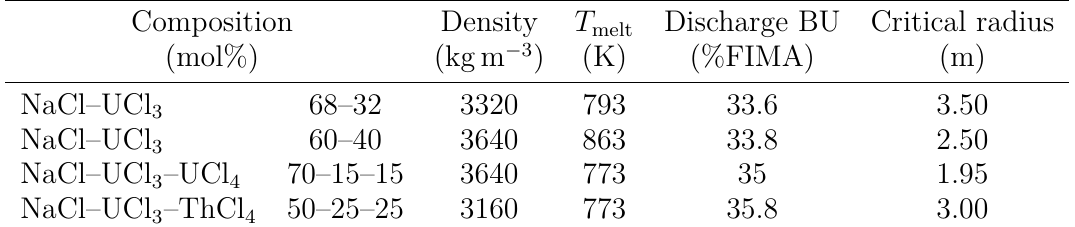
Table III: Candidate chloride fuel salts considered and their properties, adapted from